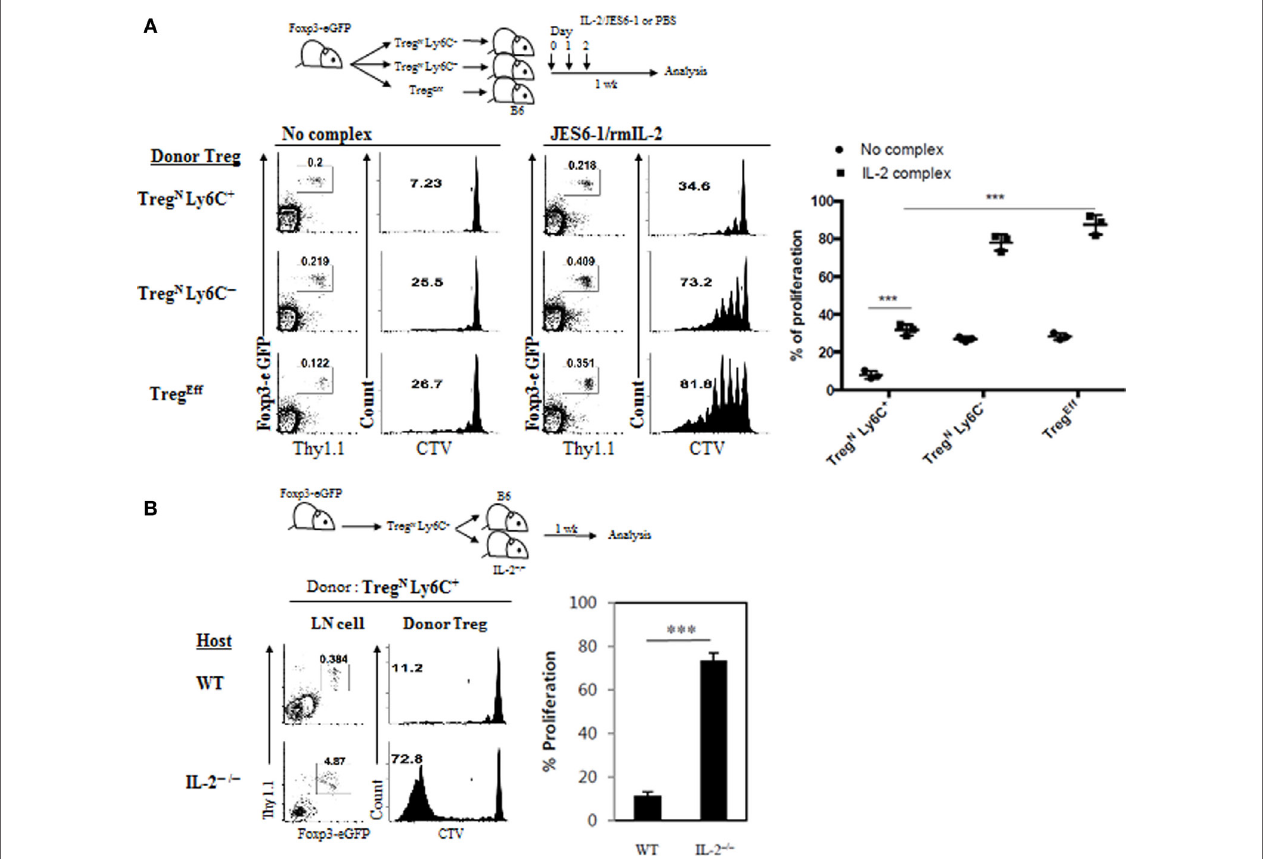
FigUre 7 | Role of IL-2 in Tconv Eff -driven functional recovery of Treg N Ly6C + subset. (a) Cell tracker violet (CTV)-labeled T regulatory (Treg) subsets were injected into wild-type (WT) hosts on day 0 and then IL-2/anti-IL-2 complexes were daily injected on days 0–2. Proliferations of donor Treg subsets were analyzed on day 7. (B) CTV-labeled Treg subsets were injected into WT or IL-2 − / − hosts on day 0 and then donor Treg proliferations were analyzed on day 7. The data are representative of three experiments comprising three mice per group. * p < 0.05, ** p < 0.01, and *** p <